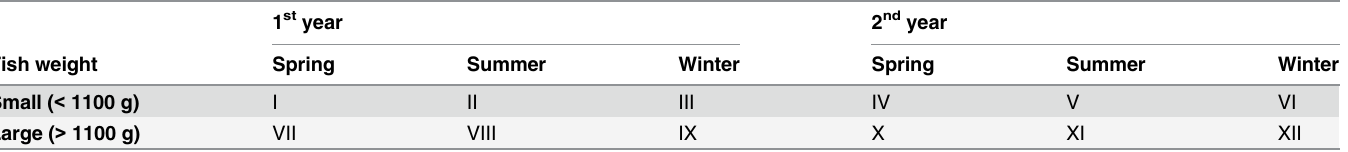
Table 1. Designation of experimental